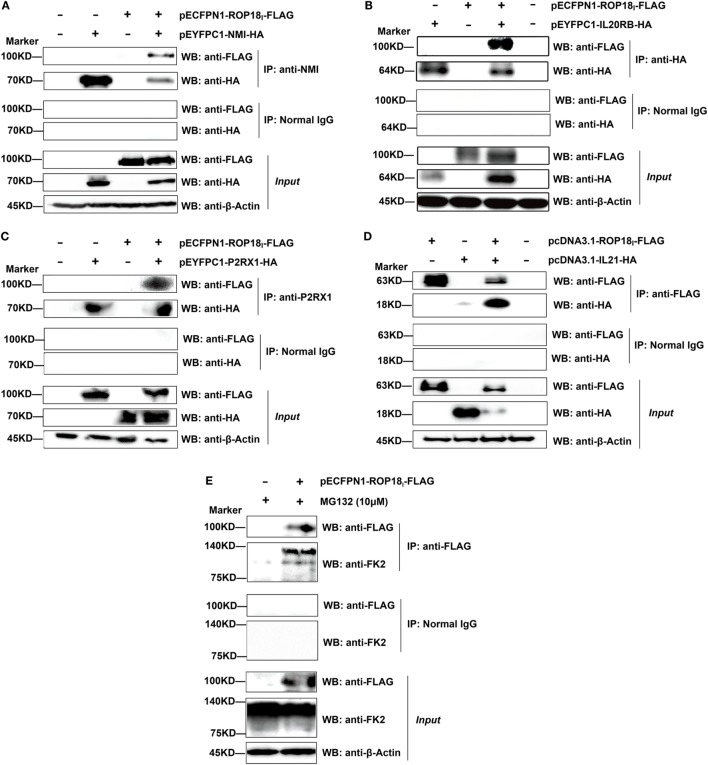
Validation of the TgROP18-interacting proteins by co-immunoprecipitation (Co-IP) assay. (A–D) Lysates of COS-7 cells co-overexpressing ROP18I and the indicated interacting proteins were immunoprecipitated with the indicated antibodies. Rabbit, mouse, or goat normal control IgG were used as negative controls. The immunoprecipitates were detected by SDS-PAGE and western blotting using the antibodies indicated. (E) Lysates of COS-7 cells overexpressing ROP18I in the presence of MG132 (10 μM) for 12 h were immunoprecipitated with the anti-FLAG antibody. Endogenous UBC (a smear of bands) was detected in the immunoprecipitates through western blotting with anti-FK2 antibody, which recognizes mono- and polyubiquitinylated conjugates.